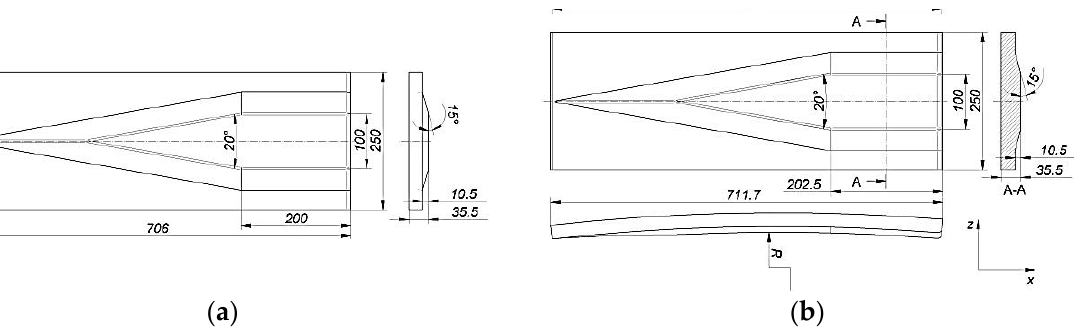
Figure 14. Geometry of the tools used for FEM analysis: ( a ) flat wedge; ( b ) concave wedge.